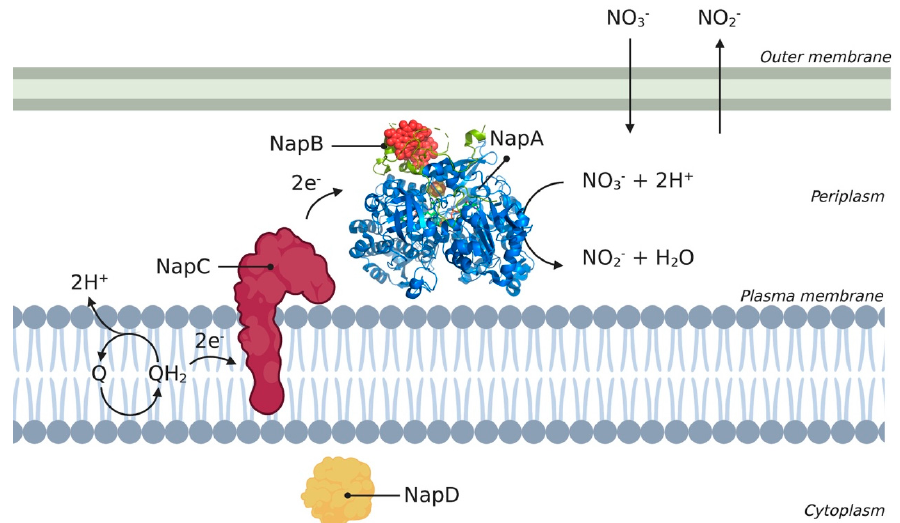
Figure 2. Schematic overview of Nap enzyme encoded from the nap operon. The different subunits (A, B, C, and D) are represented according to their location in the cell. Subunits NapA, NapB, NapC, and NapD are conserved across different species such as Cupriavidus necator , Rhodobacter sphaeroides , and Thiospaera pantotropha . The 3D structural cartoon of the C. necator NapAB (PDB:3ML1) [48] was rendered using PyMol and the figure compiled in BioRender.com [8].